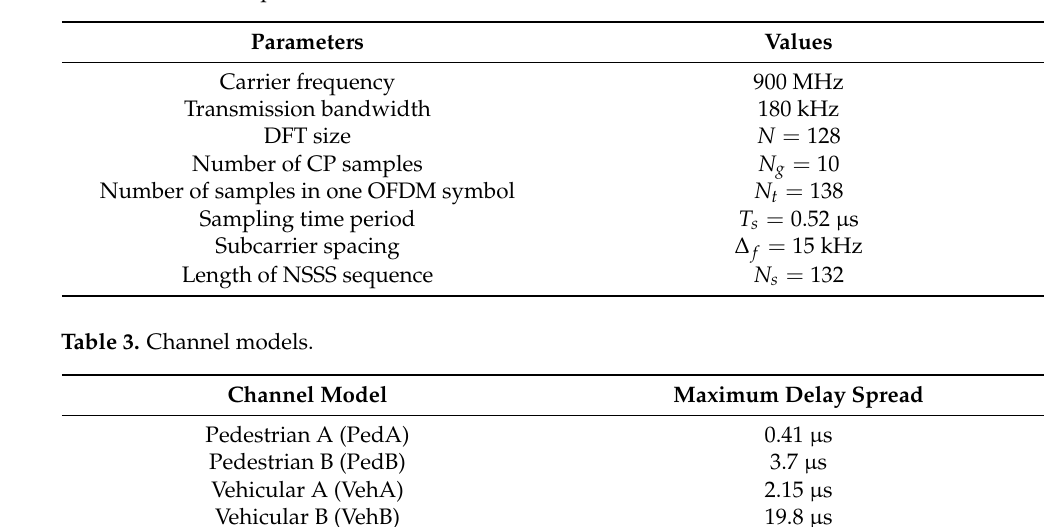
Table 2. Simulation parameters.